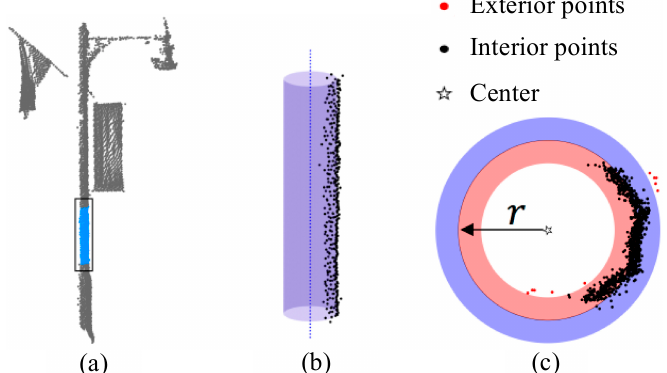
Figure 7. Cylindrical feature detection. ( a ) Street lamp and point set with independence; ( b ) Fitting cylinder; ( c ) Interior points and exterior points.